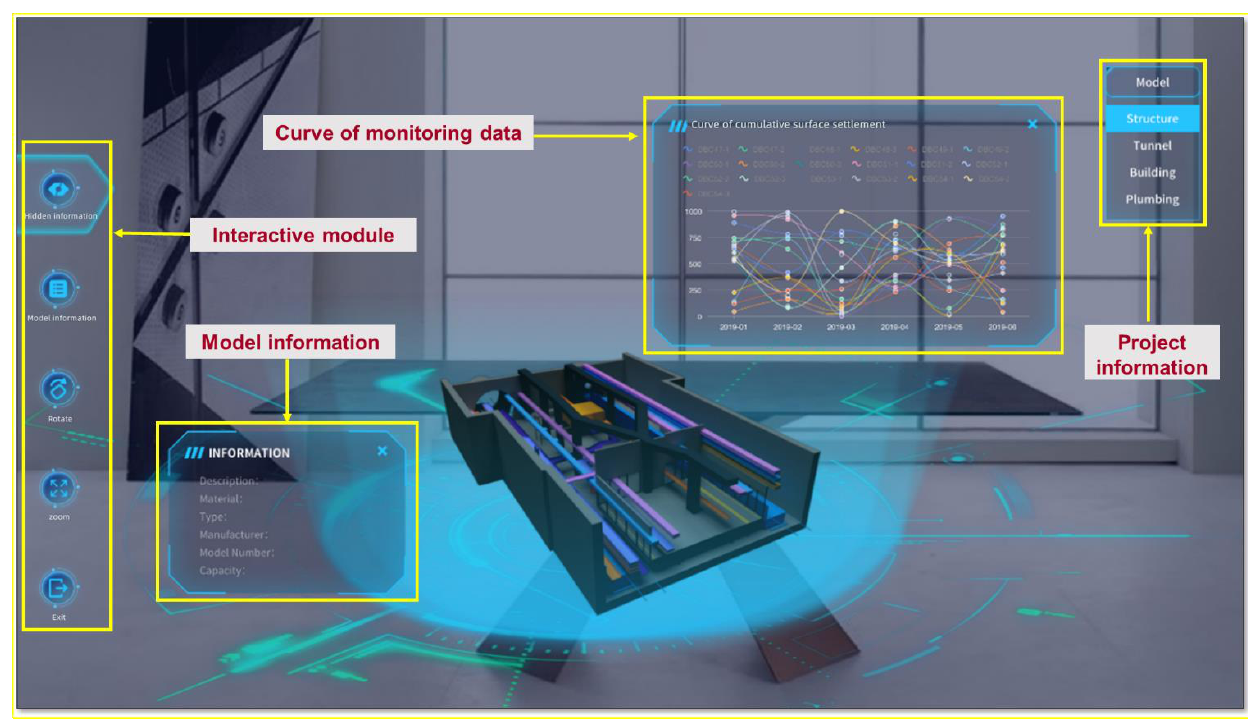
Figure 9. Waterlands Resort East Station Project of Shenzhen Metro Line 12 based on Augmented Reality Technology.